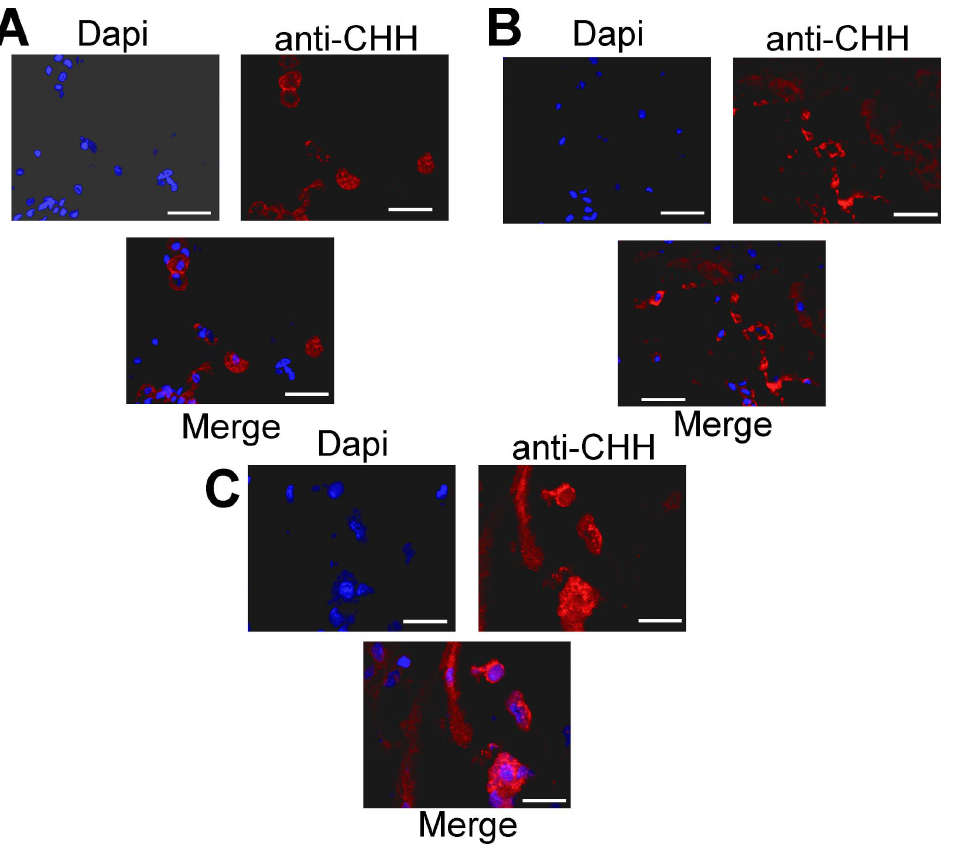
Figure 4. Imunohistochemical localization of CHH in perikarya and nuclei in the central brain of crayfish. Stacked confocal images of cluster 6 of the protocerebrum (A) and tritocerebral clusters 14 and 15 (B) and cluster 17 (C) of P. clarkii with small CHH-immunoreactive somata and some fibers (red). Nuclei are counterstained with DAPI (blue). Arrowheads show CHH-IR in the perikarya and the nuclei. Each image shows the blue (DAPI) and red (anti-CHH) channels as well as the merged image. Horizontal white bars=40 m